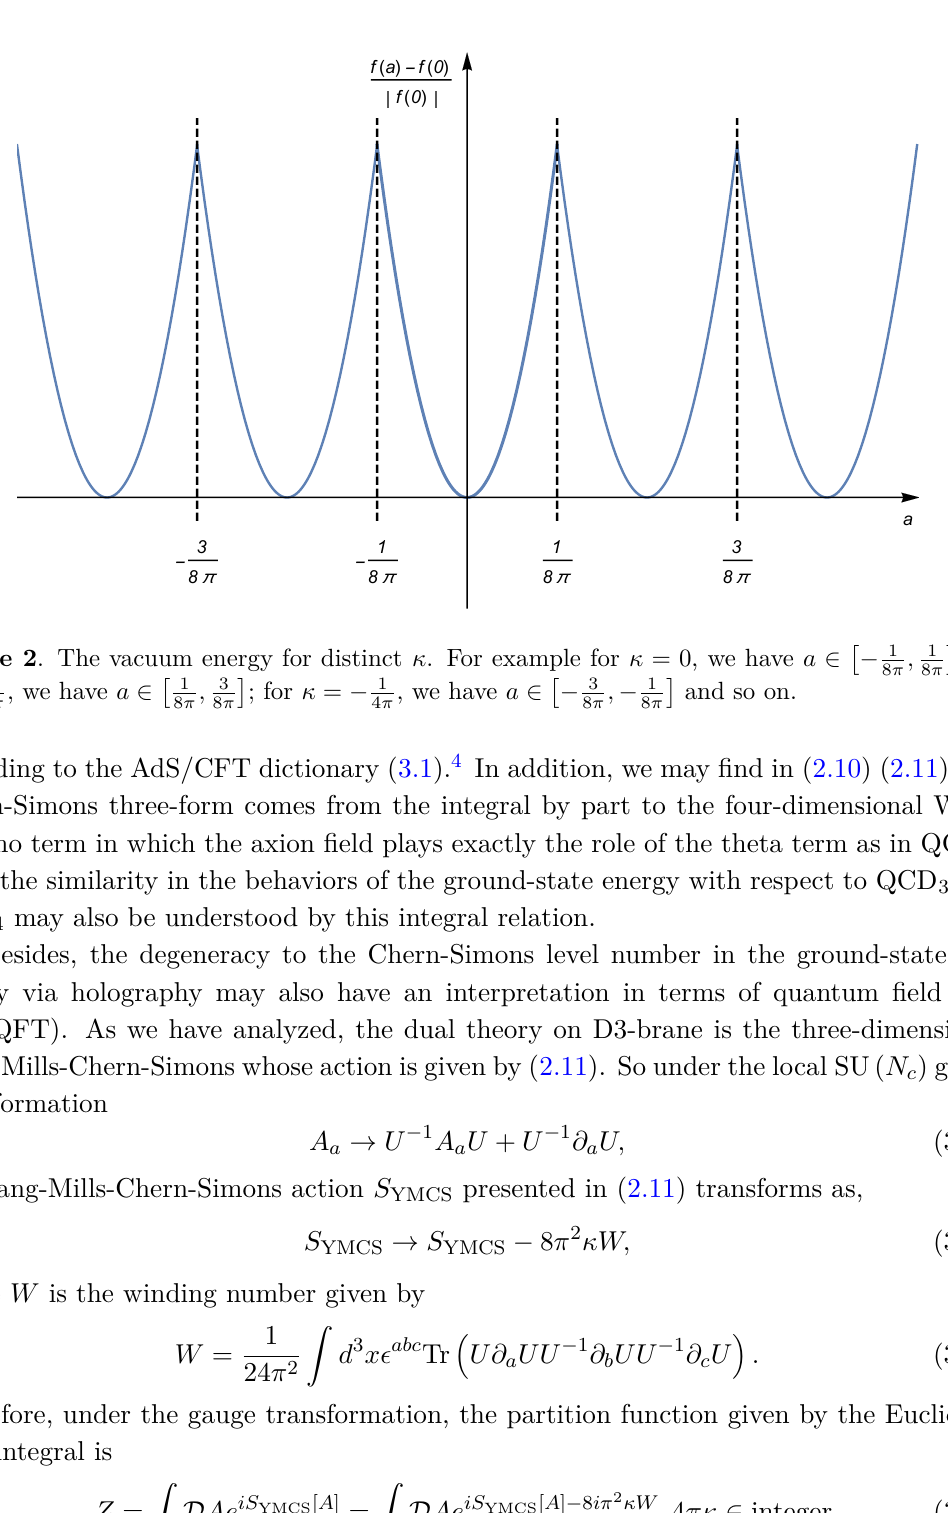
(cid:2) (cid:3) − 1 , 1 ; for 8 π 8 π